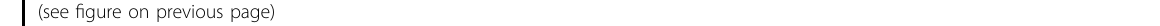
Fig. 1 Rapamycin attenuated hCPC senescence. a A cytotoxicity assay was used to assess senescent hCPCs after prolonged rapamycin treatment using an MTS kit (* p ≤ 0.05, n = 8). b Scheme of experiments. c Quanti fi cation of the length of senescent hCPCs after prolonged rapamycin treatment (** p ≤ 0.01, n = 10). d Quanti fi cation of SA- β -gal staining after prolonged treatment with different concentrations of rapamycin. e , f Measurement of the expression of the following senescent markers: p53, p21, and p16 (*** p ≤ 0.001, n = 3). g Heat map of SASP-related genes. h Expression levels of IL1A and IL6 were analyzed in senescent hCPCs after prolonged rapamycin treatment using qRT-PCR (** p ≤ 0.01, n = 3). i A count of the Hay fl ick passage numbers in the senescent hCPCs after prolonged rapamycin treatment (*** p ≤ 0.001, n = 6). j Measurement of the relative telomere